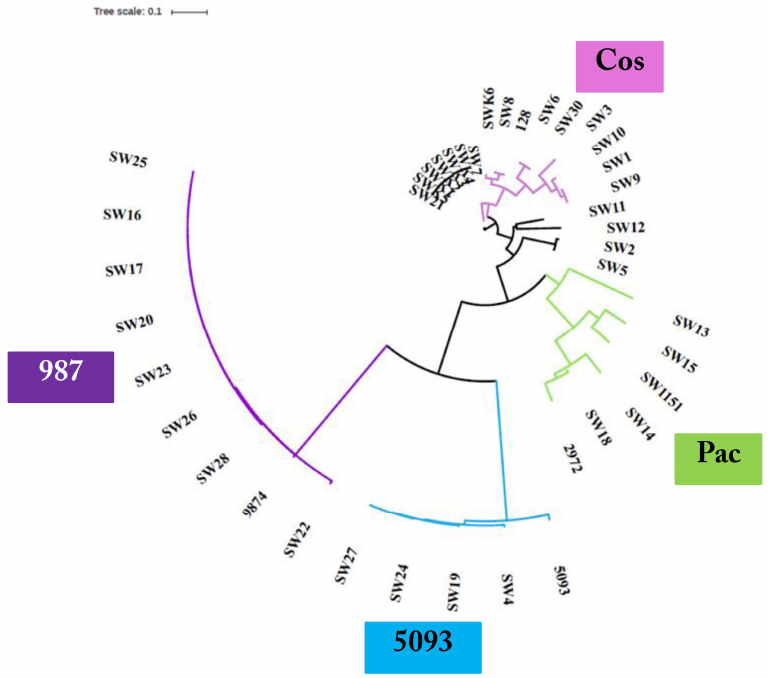
Figure 6. Phylogenetic analysis of the amino acid sequences of the encoded RBPs of the phages sequenced as part of this study. The Tal–RBP of SW13, SW31, SW32, and SW33 are 100% identical. Therefore, SW13 is used as a representative of these four phage-encoded Tal–RBPs for